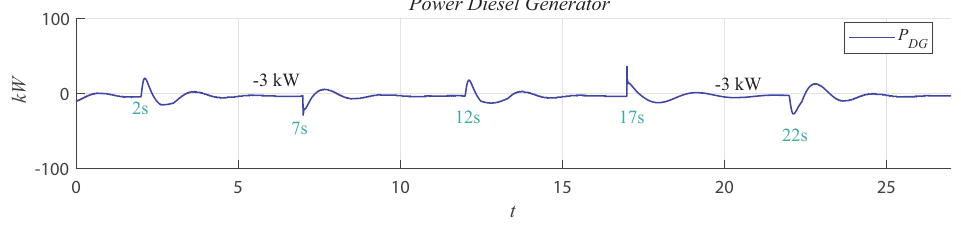
Figure 13. Power in the DG for case study 1.